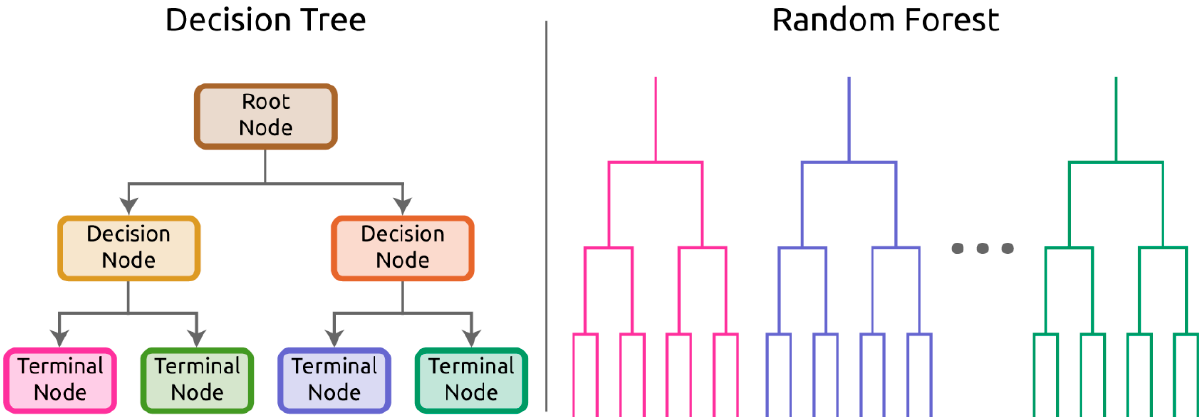
Figure 2. Decision tree (DT) showing nodes at which binary decisions are made on features. Terminal node dictates model prediction. Actual DTs have many more nodes than shown here. Random forest (RF) shown as a series of distinct decision trees.